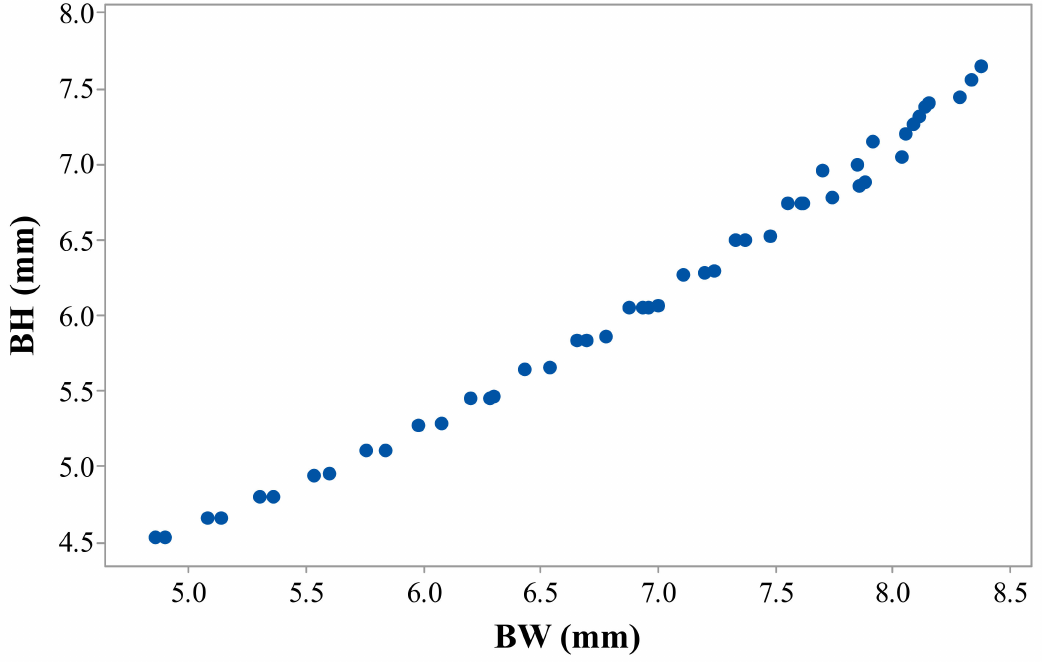
Figure 9. Pareto curve of BH vs. BW.